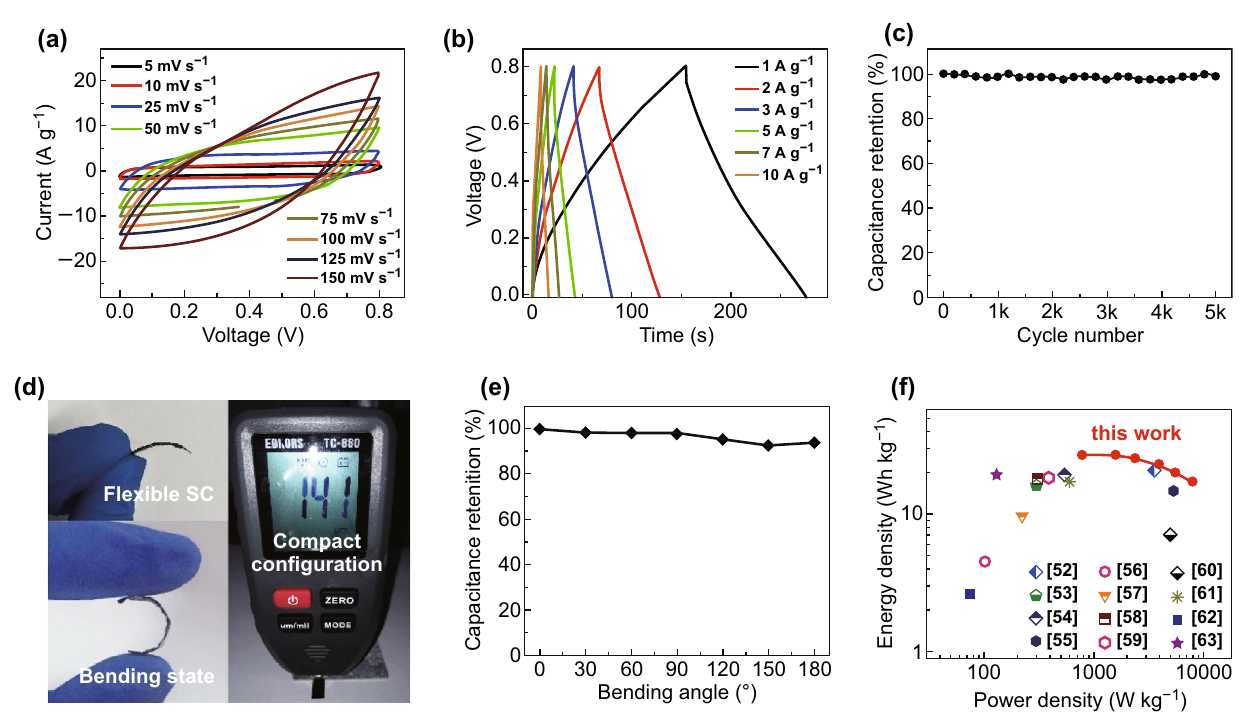
Fig. 5 a CV curves of planar solid-state SC at different scan rates, b CD curves of the planar device at different current densities, c cycle stabili- ties of the device at 5 A g −1 , d photographs of the compact and flexible SC, with a thickness of 141 μm, e capacitance retention at different bend- ing angles, and f Ragone plots of our SC device and its comparison with other devices: Cr 2 O 3 /GO/PANI [52], PANI NFs/FrGO [53], RGO/CuO/ PANI [54], CNT/PANI [55], CNF/PANI [56], HPC/PANI [57], PANI/MWCNT [58], RGO/MnO 2 @PANI [59], grapheme//MGC [60], activated carbon//MnO 2 [61], MnO-RGO//FC [62], and activated carbon//NaMnO 2